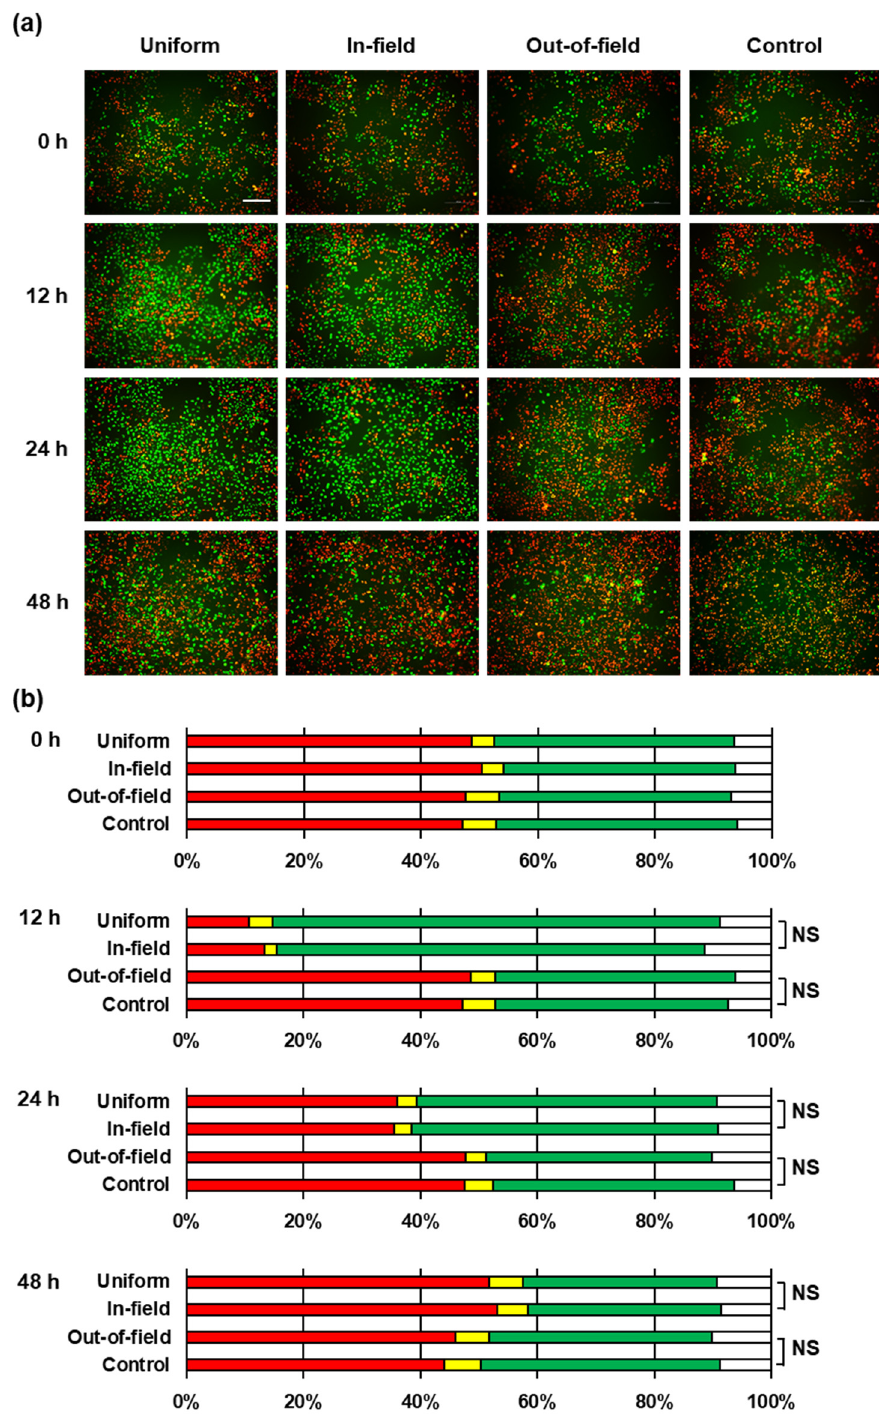
Figure 2. Cell-cycle distributions of HeLa–FUCCI cells following exposure to modulated radiation fields. ( a ) Representative fluorescent images of HeLa–FUCCI cells 0, 12, 24, and 48 h following exposure to the half irradiation field (refer to Figure 1). Cell nuclei are indicated by the red, yellow, green, and colorless regions depending on their cell cycles: G1, G1/S, S/G2, and M, respectively. Scale bar, 100 μ m. ( b ) Summary graph of fluorescent color distributions in HeLa–FUCCI cells after the control, out-of-field, in-field, and uniform exposures. The color of the bars indicates the color of the cells, respectively. There was no difference in the cell-cycle distribution between the uniform and the in-field exposures and between the control and the out-of-field exposures, which suggested that there was no detectable, non-targeted effect. NS stands for Non-Significant (chi-square test).